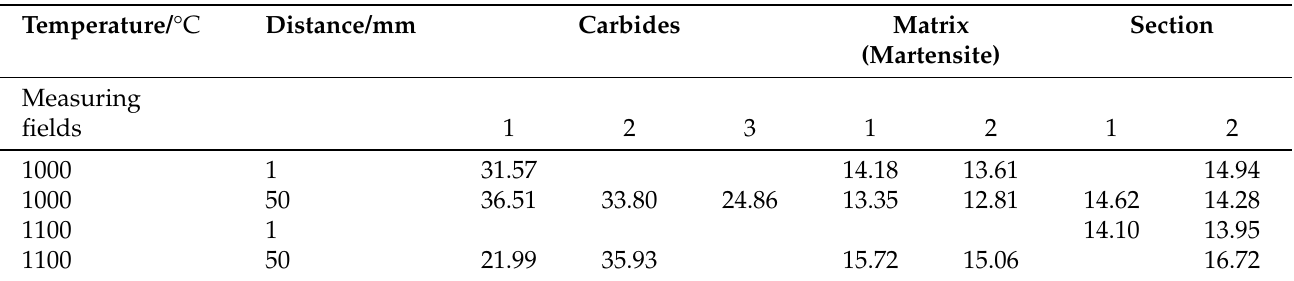
Table 7. Mass fraction of chromium in % measured by EDX Analysis using SEM. In addition to the chromium content, the content of silicon, sulfur, manganese, and iron was determined. The mass fractions of carbon were not considered in the quantification because the atomic number of carbon is only six. At 1100°C and 1mm, no chromium content of the carbides could be determined because no carbides were recognizable or they were too small. Therefore, a larger section is analyzed. This is assumed to be the matrix (mainly martensite with small fractions of retained austenite). Please note that the analyzed sections cover different areas/volumes, each with different fractions of carbides, compare Figure 18 (pink